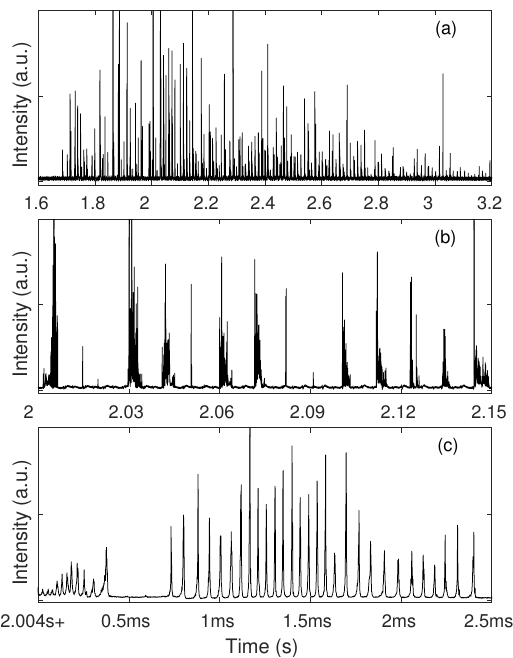
Figure 3: A typical example (EAST #70273) shows the pattern of the occurrence of the ω pe bursts: (a) time scale of 1.6 s, (b) time scale of 150 ms, (c) time scale of 2.5 ms.